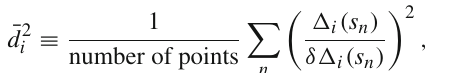
Fig. 8 Results for forward dispersion relations. Blue lines: real part coming from our new parameterizations. Orange lines: the result of the dispersive integrals. The gray bands cover the uncertainties in the difference between both. From top to bottom: a the π 0 π 0 FDR, b the π 0 π + FDR, c the FDR for I = 1 scattering t